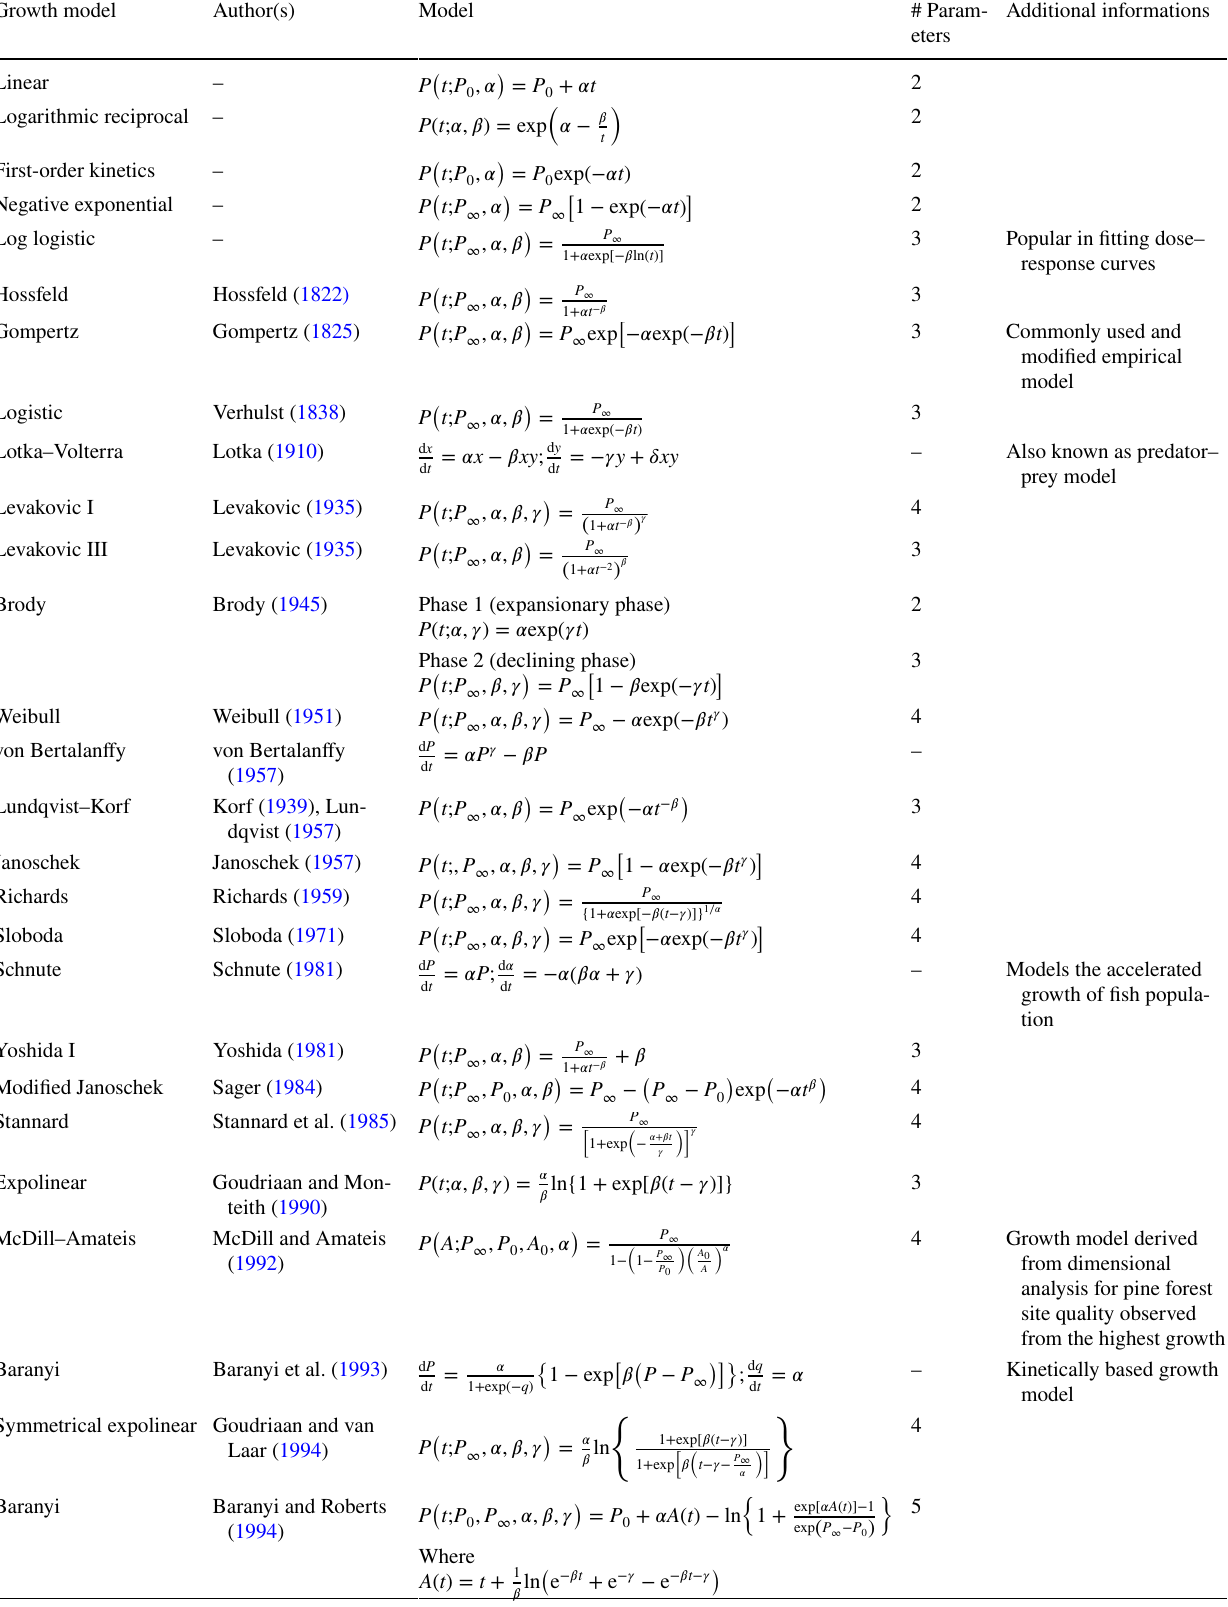
Table 2 Summary of growth